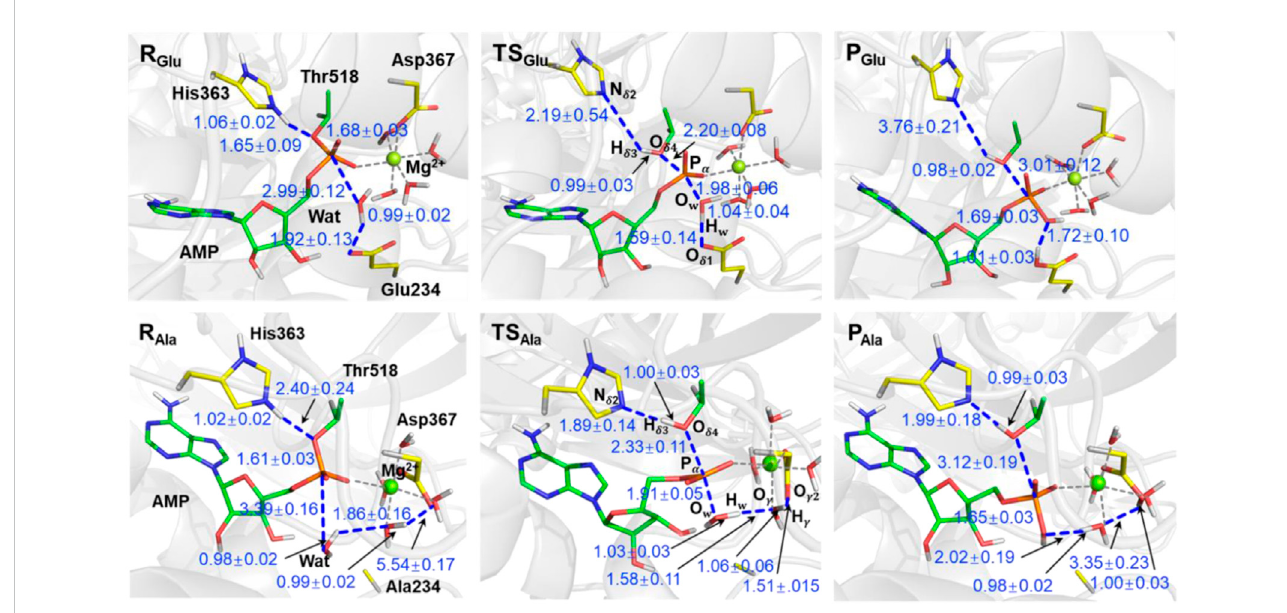
FIGURE 3 Representative structures of reactants (R), transition states (TS), and products (P) identi fi ed according to the free energy pro fi le of Figure 2. Structures in the wild type and Glu234Ala mutant system are distinguished by the subscript (Glu and Ala). Atoms are coloredfor clarity, C (yellow for residues and greenfor AMP), P (orange), O (red), N (blue), and H (white). Distances are given in